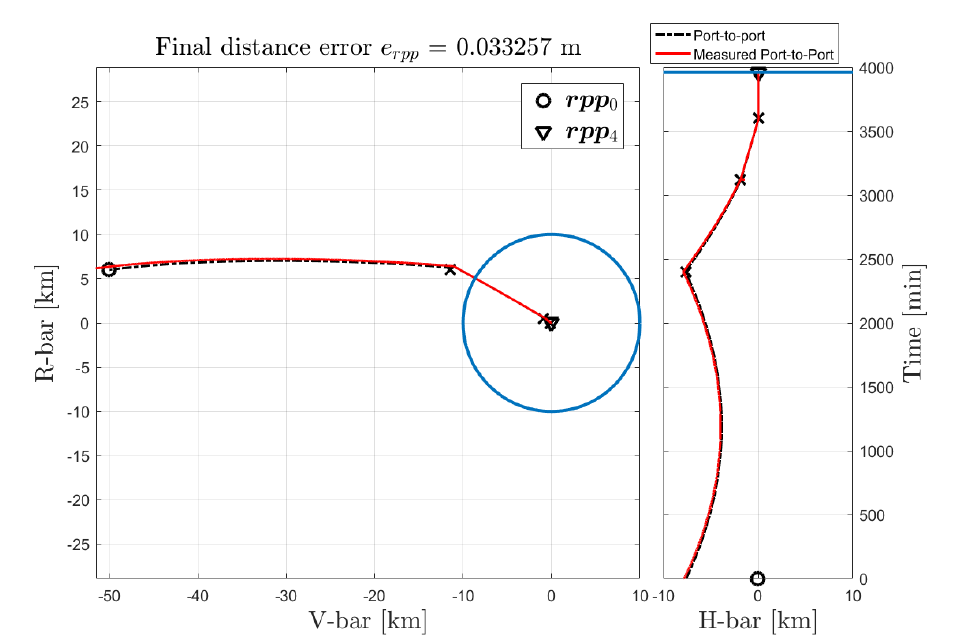
Figure 28. Rendezvous trajectory-LVLH. Figure 29 shows the relative velocity components between chaser and target. The relative attitude is shown in Figure 30. In both cases, the contribution of sensors and actuators models is shown in red as compared to the ideal case (black line).